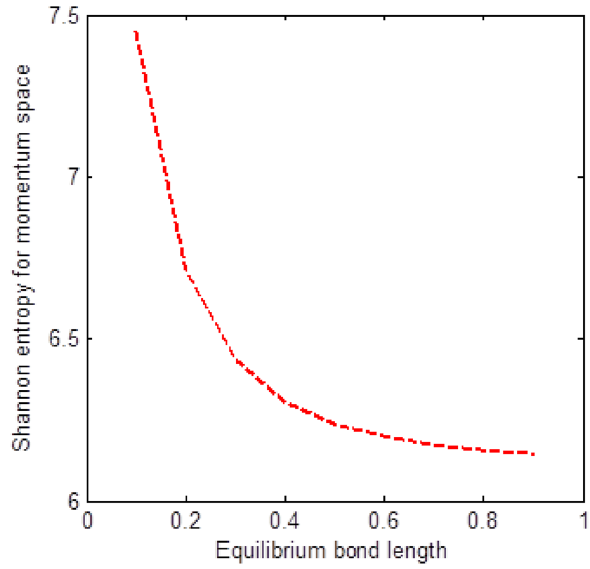
Figure 2. Shannon entropy for momentum space against the equilibrium bond length with µ = ℓ = (cid:31) = 1, n = D e = C = 1, and (cid:31) = 2 C of the multiple potential functions.